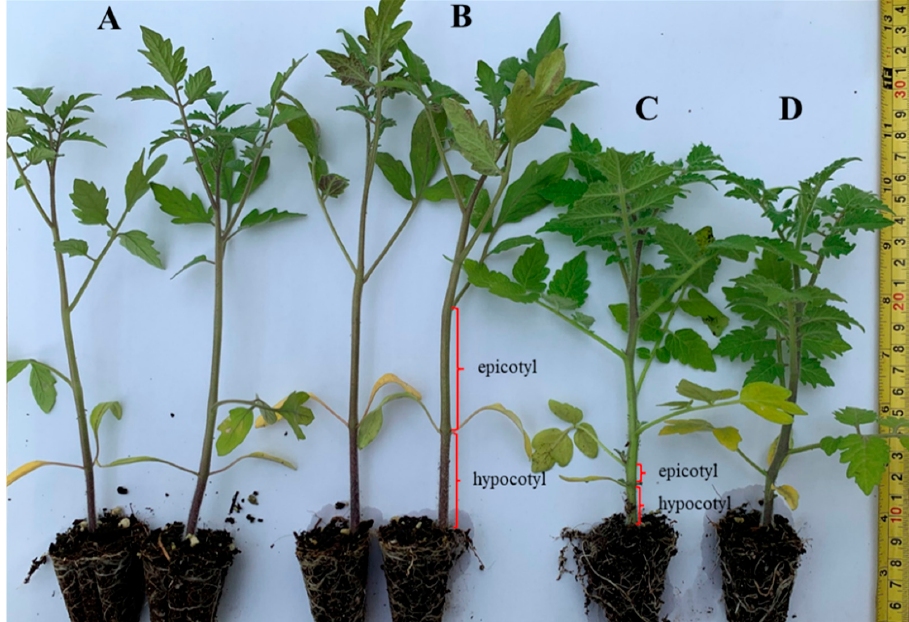
Figure 1. The hypocotyl length and epicotyl length of S. l and S. h at 30 DAS. A: JTS01-3, B: JTS21-1, C: SN-14, D: SN-41.